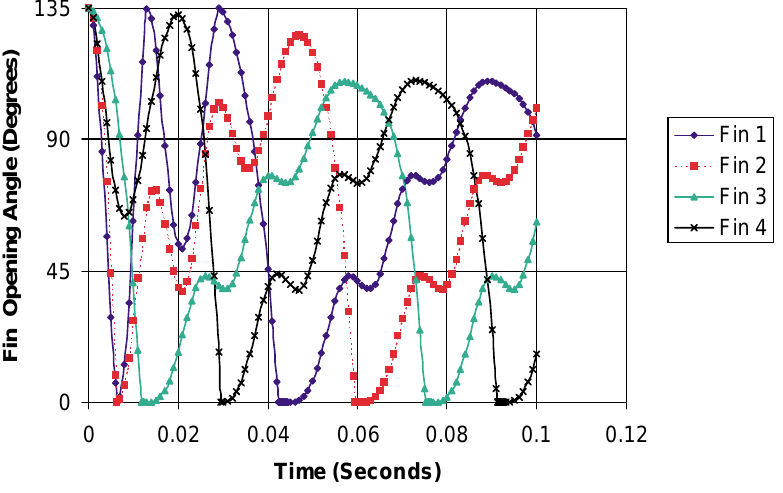
Fig. 15. Fin opening angle as a function of time, no locking mechanism, 5 degrees of yaw, 15.6 Hz spin